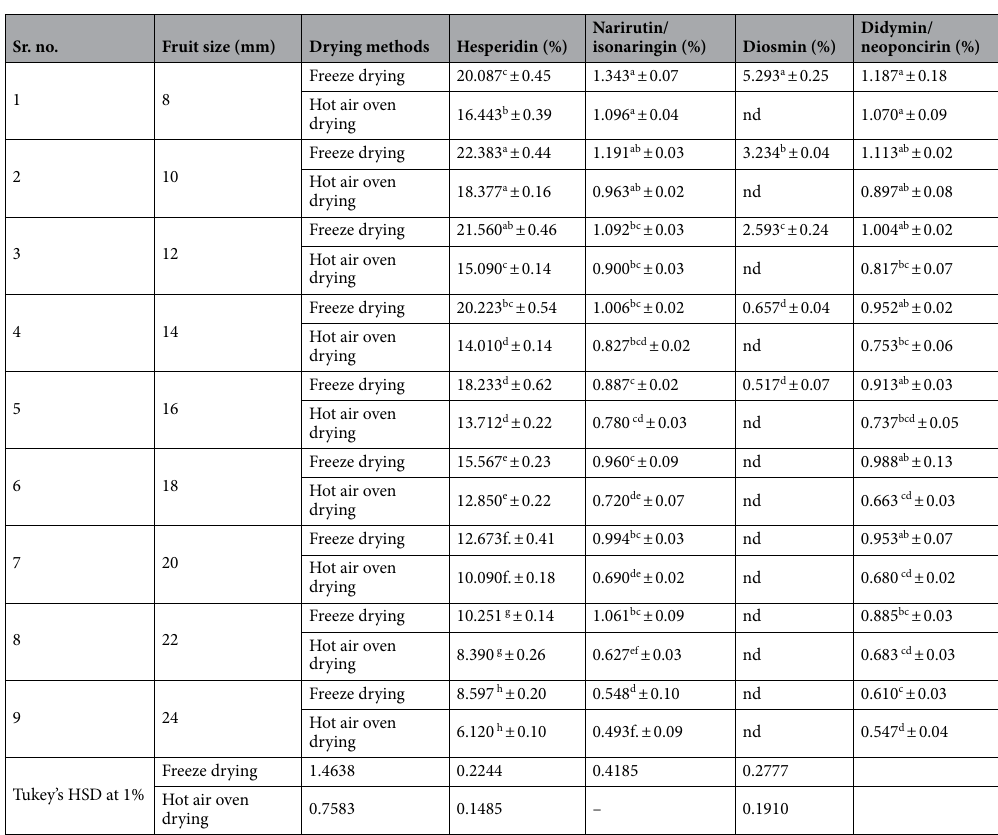
Table 1. Flavonoids profile (relative %) after different drying techniques (freeze drying for about 48 h and hot air oven drying for about 36 h) in C. sinensis L. Osbeck immature dropped fruits. nd not detected. Data presented is analyzed in three replicated trials and expressed as means ± standard deviation. Values with different superscripts in a column are significantly different at p < 0.01 according to the Tukey’s honestly significant difference (HSD) multiple range test, Values with same superscripts are not significantly